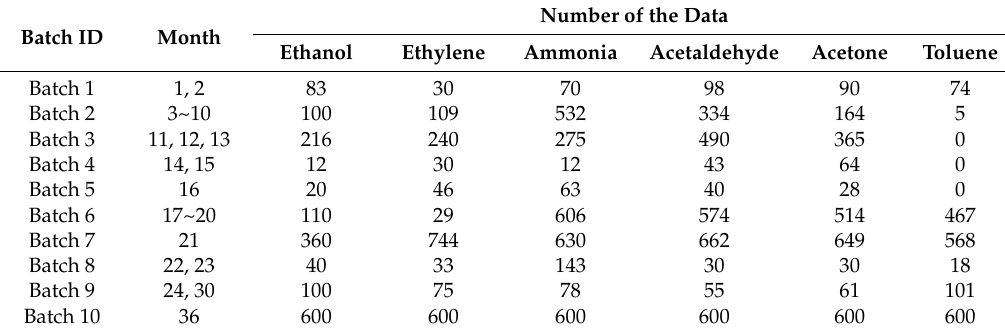
Table 4. Experimental long-term sensor drift big